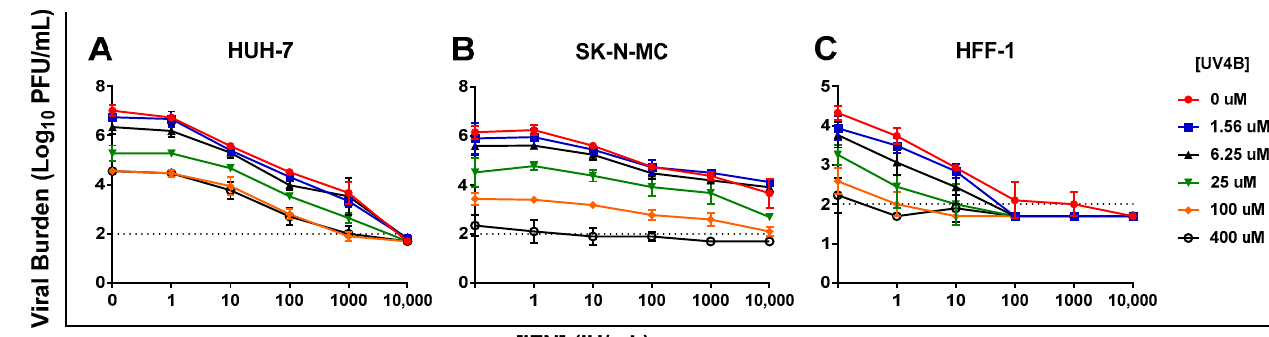
Figure 5. Antiviral activity of UV-4B and interferon-alpha (IFN) combination therapy against dengue virus (DENV) in HUH-7 ( A ), SK-N-MC ( B ), and HFF-1 ( C ) cells. HUH-7 cells were infected with DENV at an MOI of 0.01, and SK-N-MC and HFF-1 cells were infected at an MOI of 0.1 Different concentrations of UV-4B, IFN, or both were added to cells following infection. Viral supernatant was sampled when peak viral titers were achieved in the control (Day 1 for HFF-1 cells and Day 2 for HUH-7 and SK-N-MC cells) and viral burden was quantified via plaque assay on Vero cells. Data points represent the mean of three independent samples and error bars correspond to one standard deviation. The dashed line signifies the assay limit of detection.